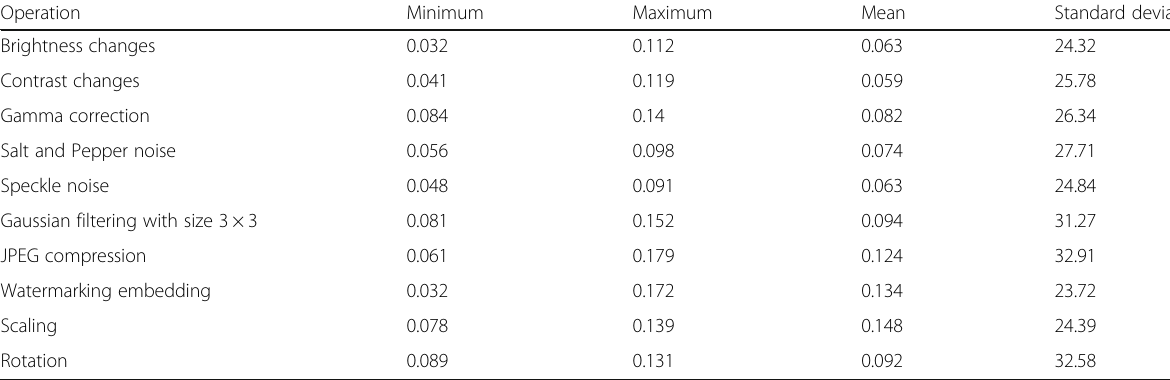
Table 4 Robustness results of 53 × 76 = 4024 image